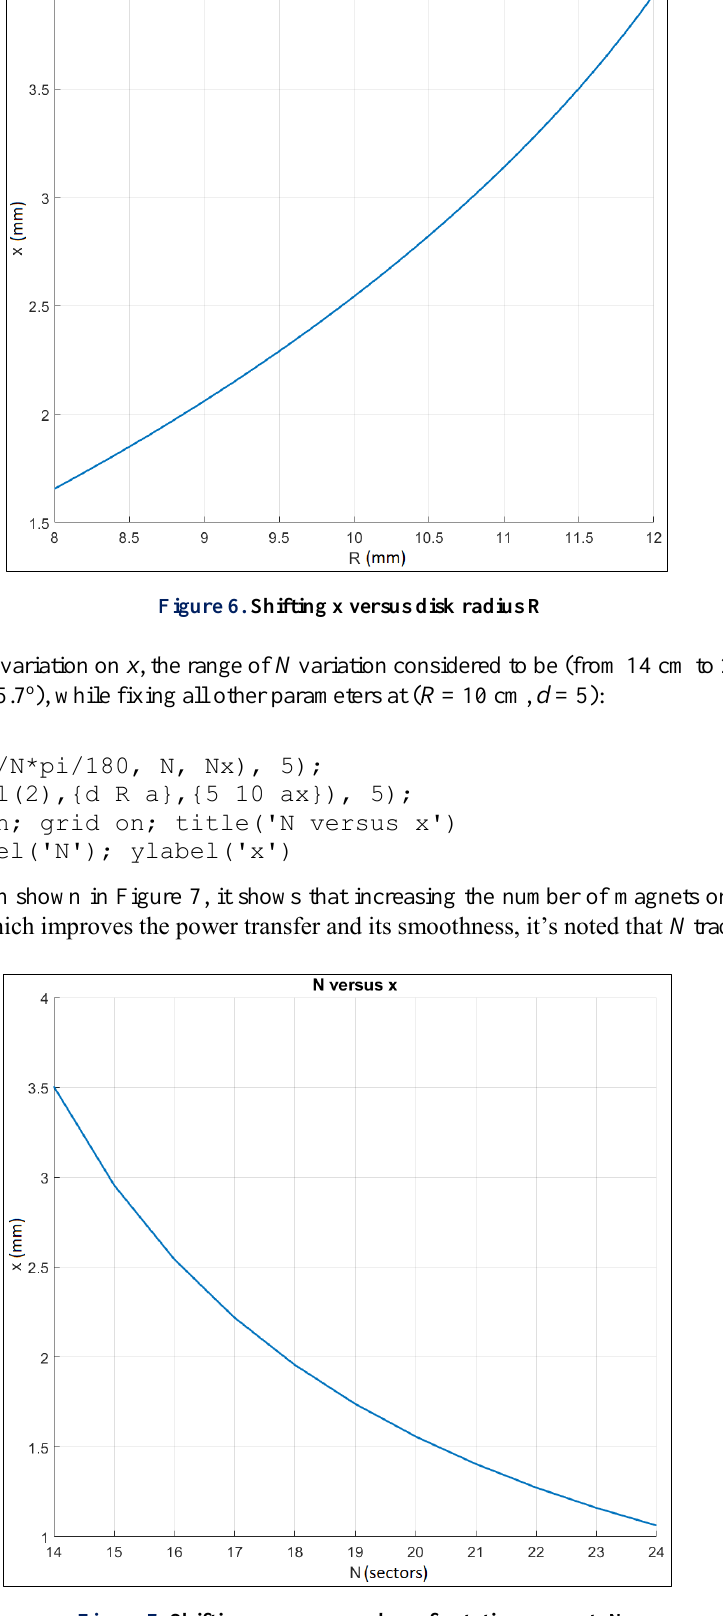
Figure 7. Shifting x versus number of rotating magnets